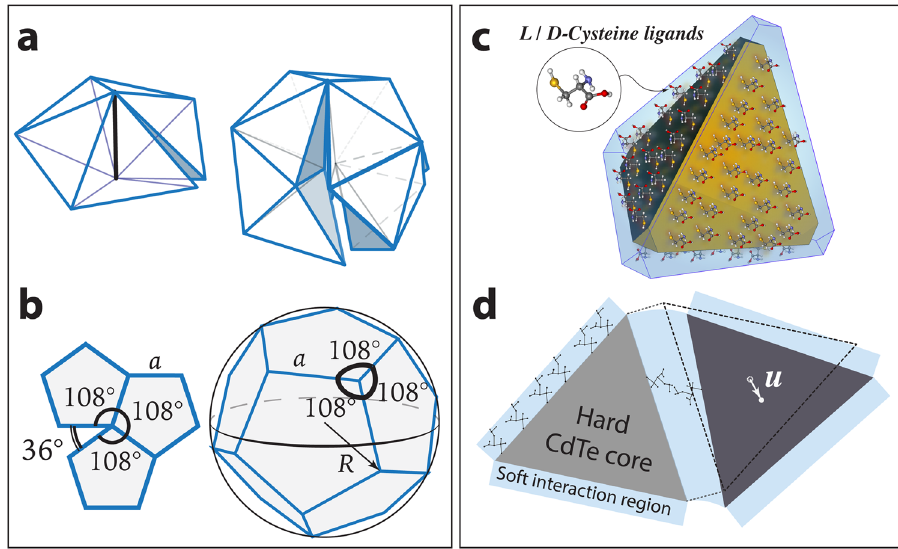
Fig. 1 Geometric frustration of polyhedra and polygons, and tetrahedral NPs. a Five tetrahedra can almost form a pentamer; 20 tetrahedra can almost form an icosahedron. b A 2D example of geometric frustration: pentagons do not tile Euclidean surface, but can form a regular crystal (dodecahedron) on the 2-sphere S 2 . c CdTe tetrahedral NPs (yellow tetrahedra) are coated with a layer of chiral ligands ( L - or D -Cysteine). The blue-shaded areas represent the soft interaction regions where coordination bridges between ligands can form. d Elastic deformations in this continuum theory represent distortions of the soft ligand